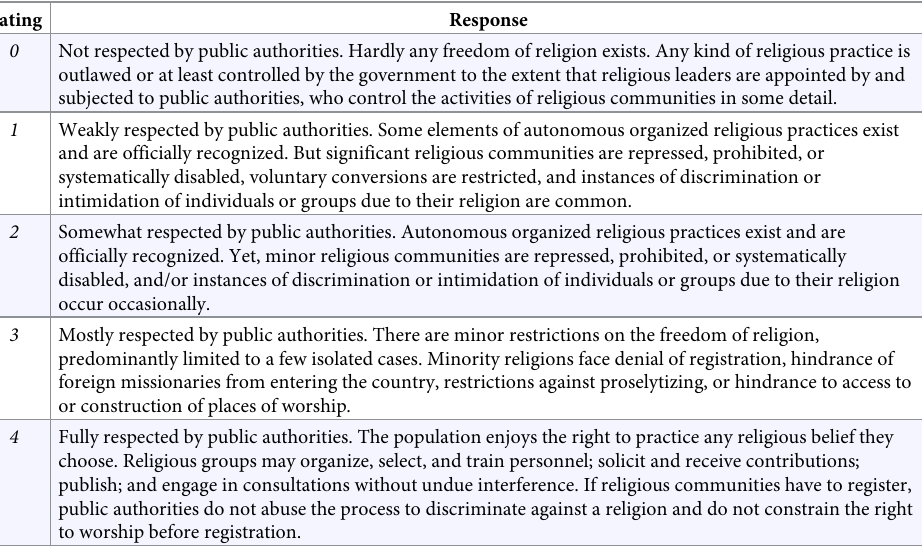
Table 2. Measuring religious liberty across